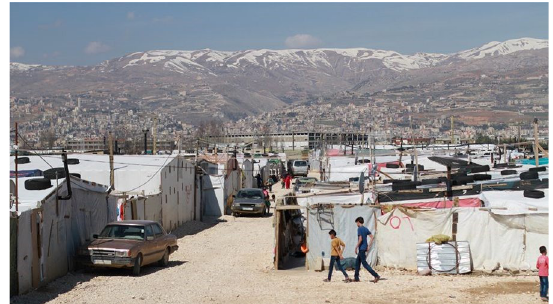
Fig. 2 View of Dalhamieh informal settlement in East Bekaa, Lebanon (Source: Amid deepening poverty, cash assistance keeps vulnerable refugees afloat. https:// www. unhcr. org/ lb/ 11158- amid- deepe ning- pover ty- cash- assis tance- keeps- vulne rable- refug ees- afloat. html). Credit: UNHCR/Elie